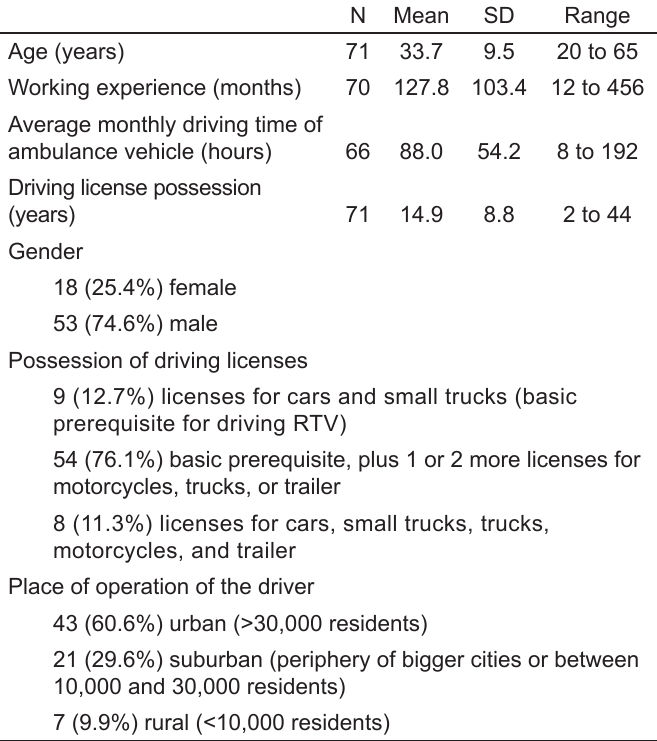
RTV , rescue transport vehicle; SD , standard